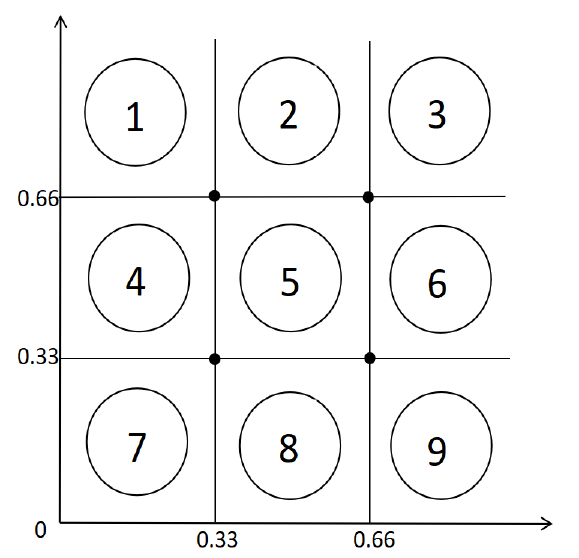
Figure 7. An example of feasible region division.